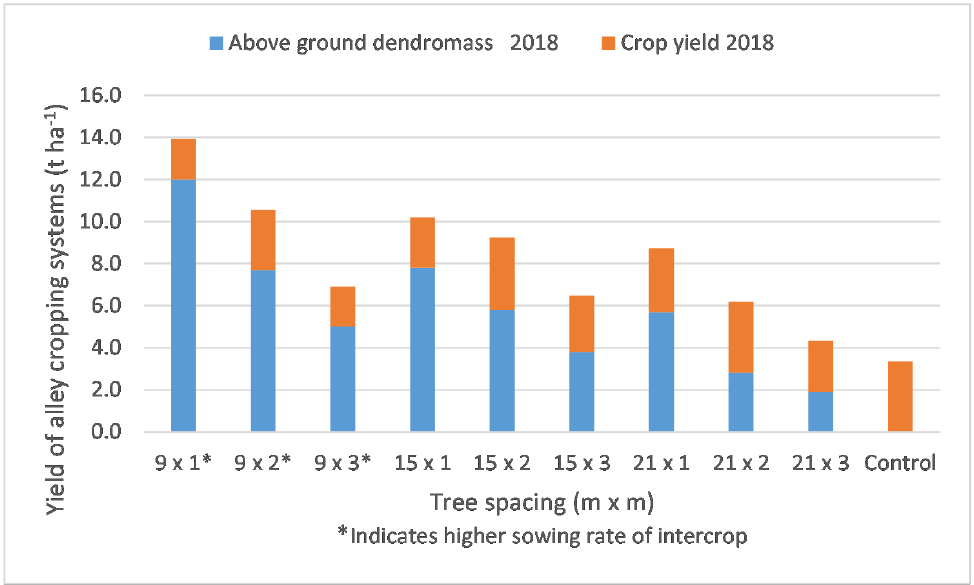
Figure A1. Yields of triticale–black locust alley cropping systems in 2018 according to the tree spacing, based on above-ground dendromass. The trees were 4 years old.